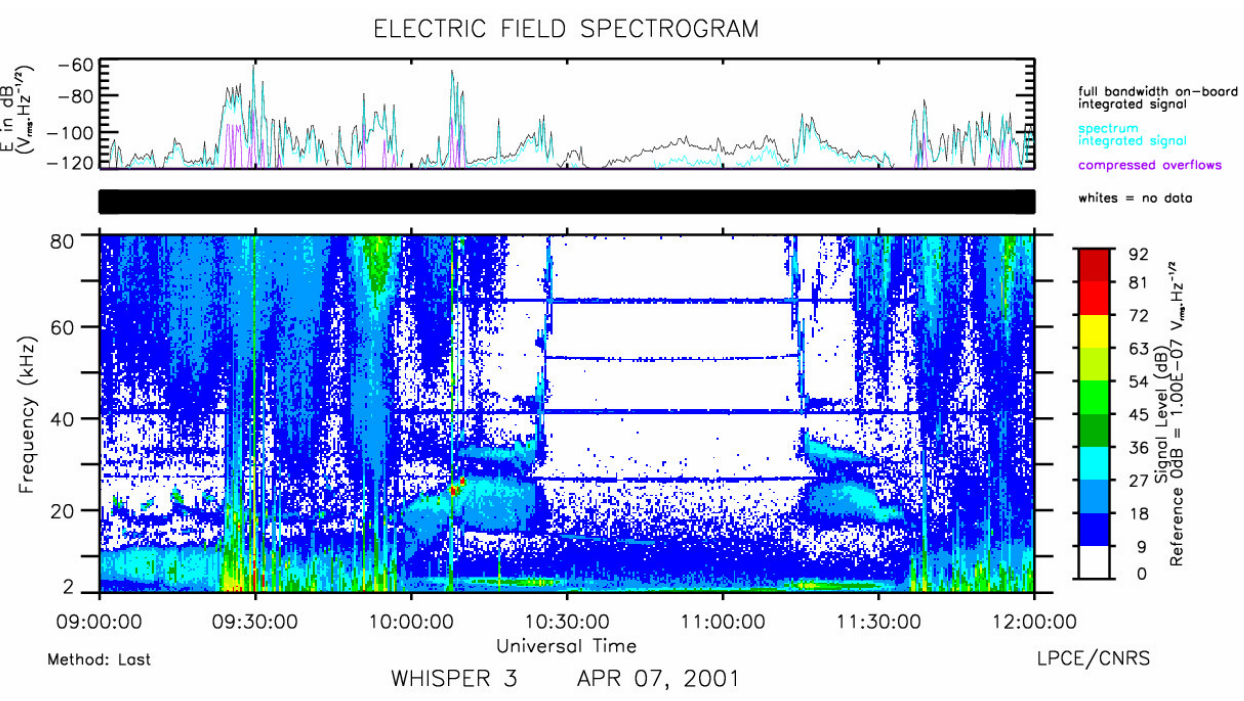
Fig. 3. Spectrogram of VLF signal strength measured by the WHISPER instrument on board the Cluster 3 satellite during ∼ 09:00 to 12:00 UT on 7 April 2001 (bottom panel). The signal strength integrated over the full receiver bandwidth is also shown (top panel). Plasmapause crossings occurred during 10:24–10:27 UT (entry) and 11:13–11:16 UT (exit).